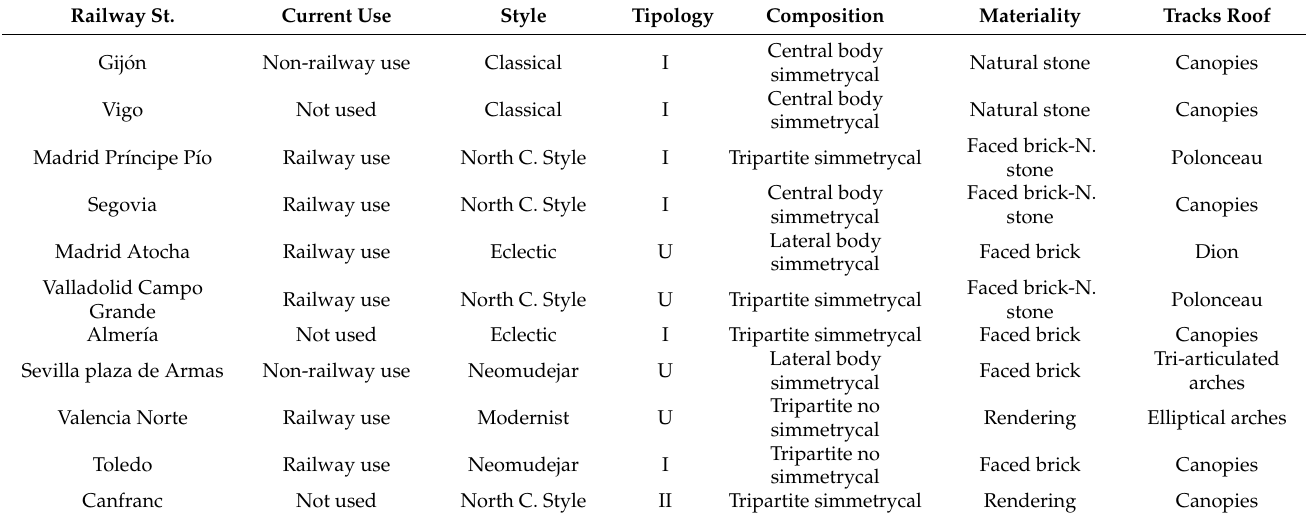
Figure 11. Current use stations. Own elaboration. The following table (Table 2) contains the details of the architectural variables analysed. Table 2. Architectural variables. Own elaboration.